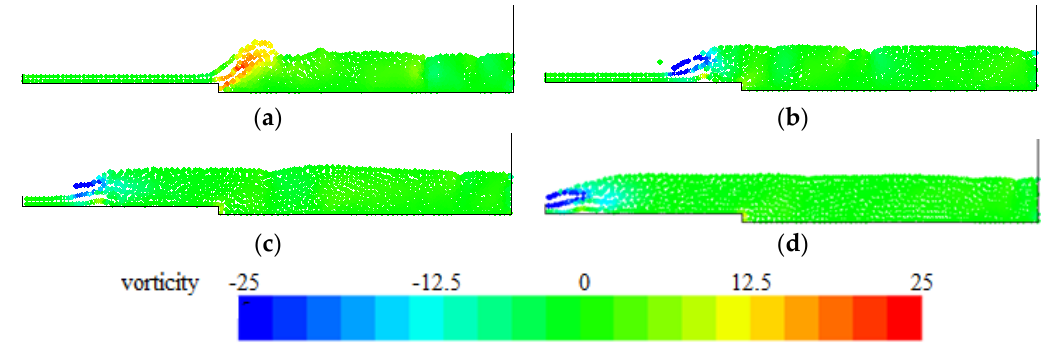
Figure 5. Instantaneous SPH vorticity field in the SPH simulation of Test T1a with an initial particle spacing equal to 0.015: ( a ) t = 6 s; ( b ) t = 9 s; ( c ) t = 12 s; and ( d ) t = 15 s. Vorticity values in the colour scale are expressed in s −1 .